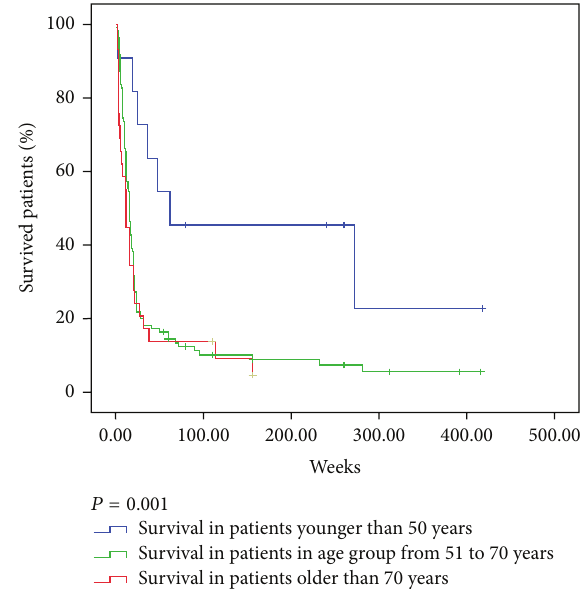
Figure 1: Kaplan-Meier survival curve in patients with anaplastic thyroid cancer in relation to